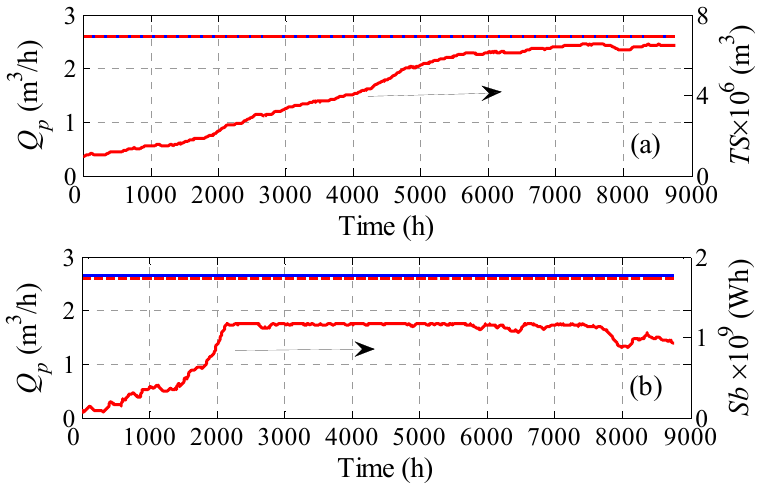
Figure 9. Plant production rate when the plant storage is initialized, ( a ) using storag tanks; ( b ) using energy storage; Q p : hourly production rate, Ts : Tank storage capacity; Sb : Battery storage capacity.